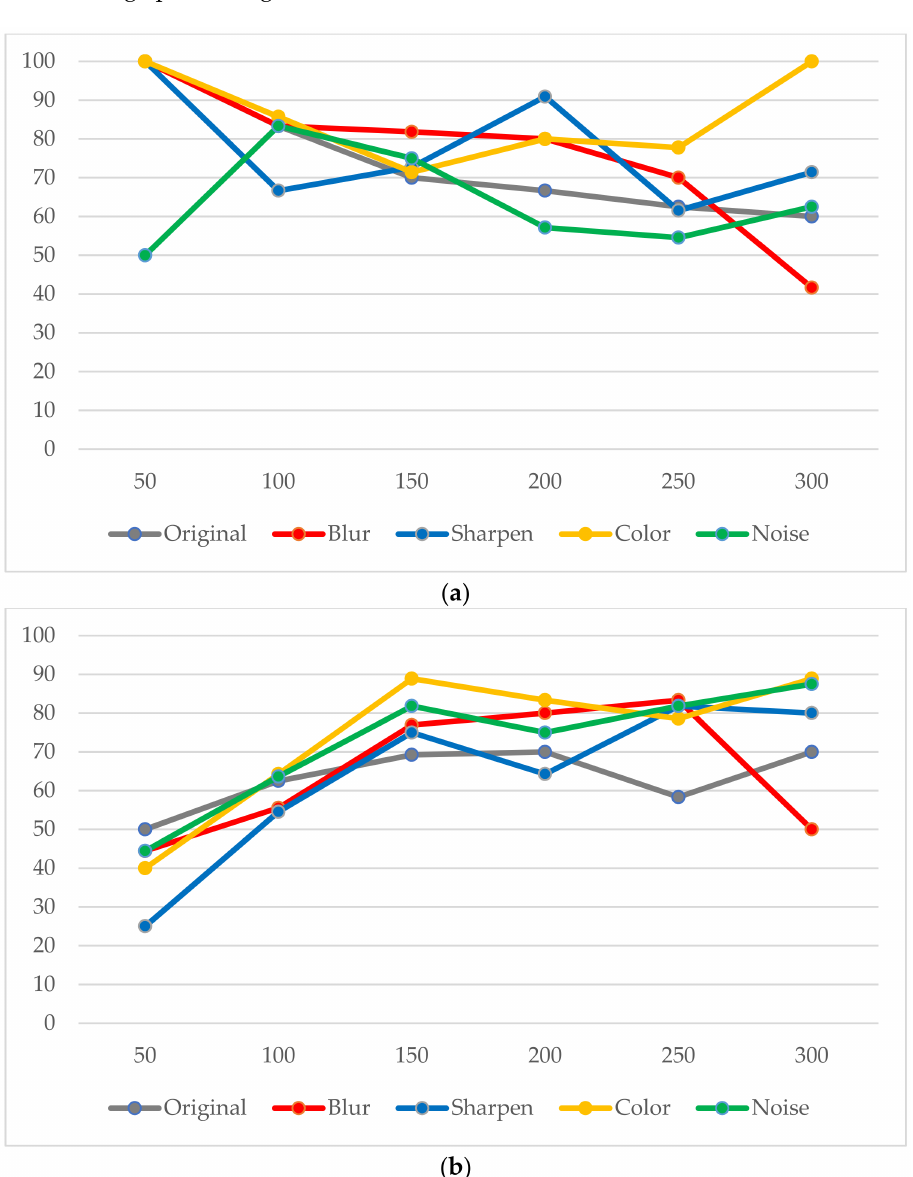
Figure 8. The learning curves of panoramic accuracy ( a ) and cross-sectional accuracy ( b ) of each trained